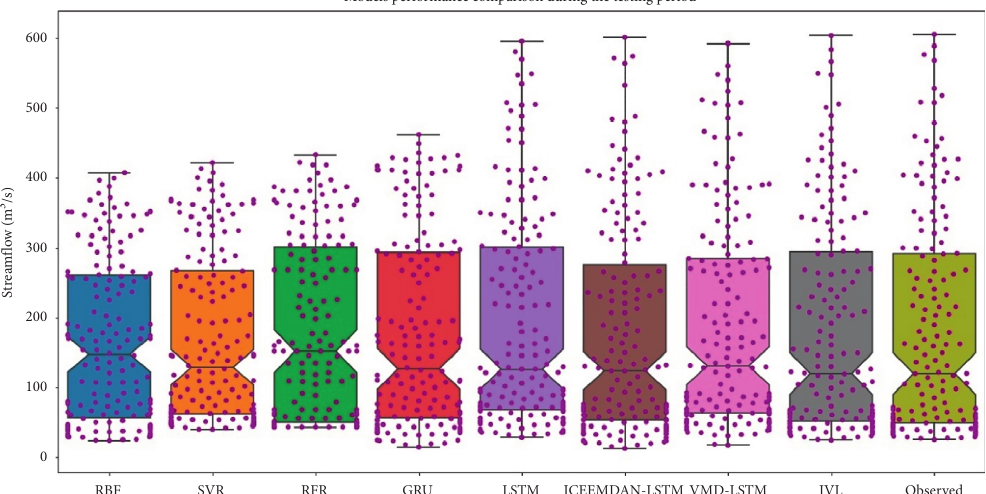
Figure 14: Boxplot of observed and predicted streamflow using RBF, SVR, RFR, GRU, LSTM, ICEEMDAN-LSTM, VMD-LSTM, and IVL models for the testing